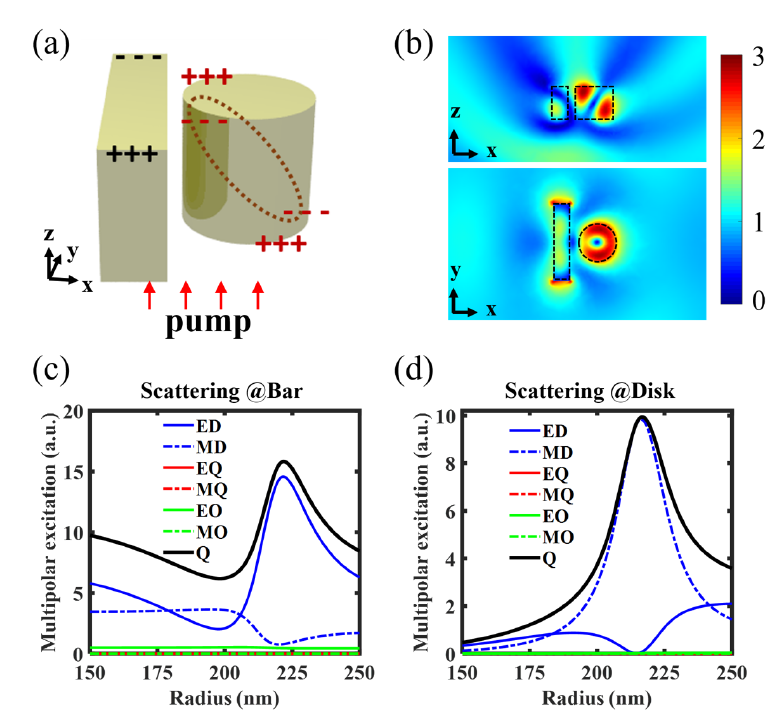
Figure 6. ( a ) Schematic of the designed asymmetric AlGaAs nanoantennas; ( b ) near-field distribution of the electric field under the normal plane wave pump with wavelength λ = 1550 nm; ( c ) multipolar excitations within the nanobar as a function of the disk radius; ( d ) multipolar excitation within the nanodisc as a function of the disk radius.